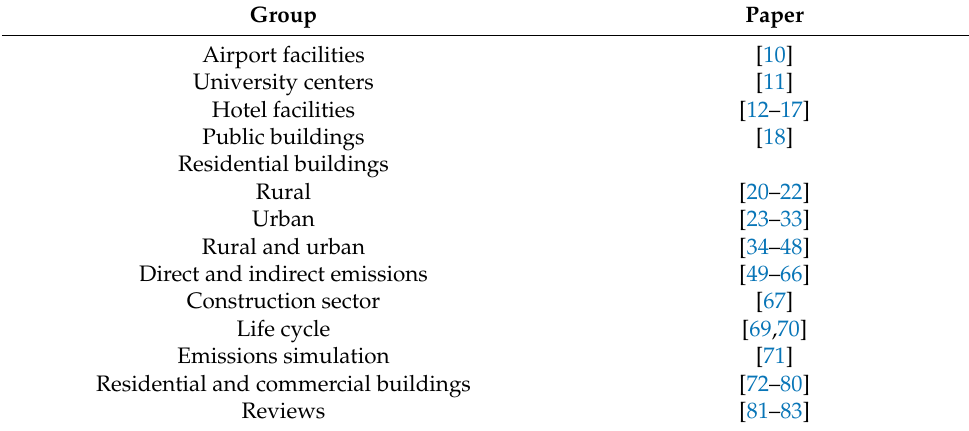
Table 1. Classification of papers. Group